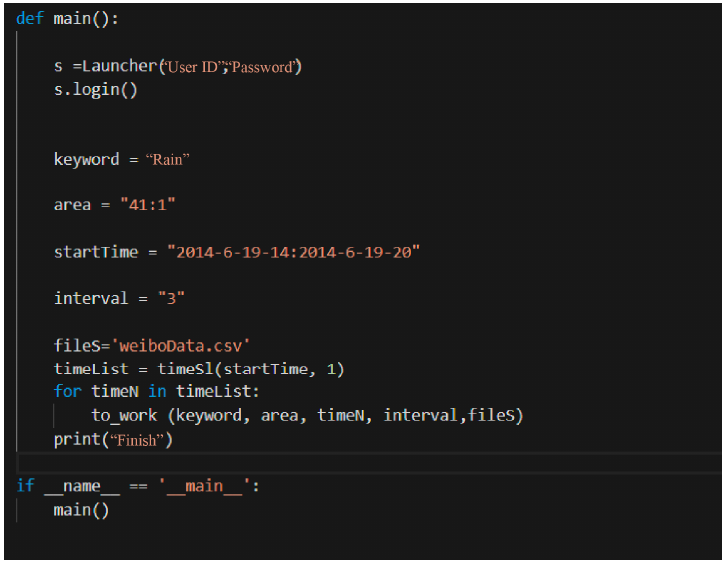
Figure 5. Part of the web crawler code that crawls the unstructured data.